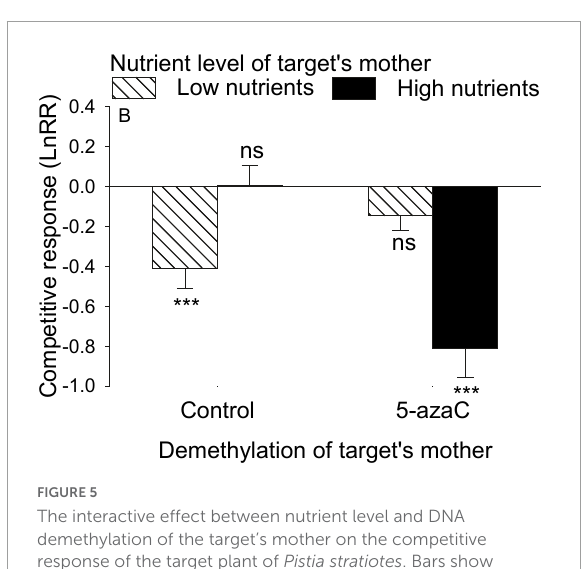
FIGURE5 The interactive effect between nutrient level and DNA demethylation of the target’s mother on the competitive response of the target plant of Pistia stratiotes . Bars show means + SE. Symbols (*** P < 0.001) indicate significant difference from zero (by one-sample t